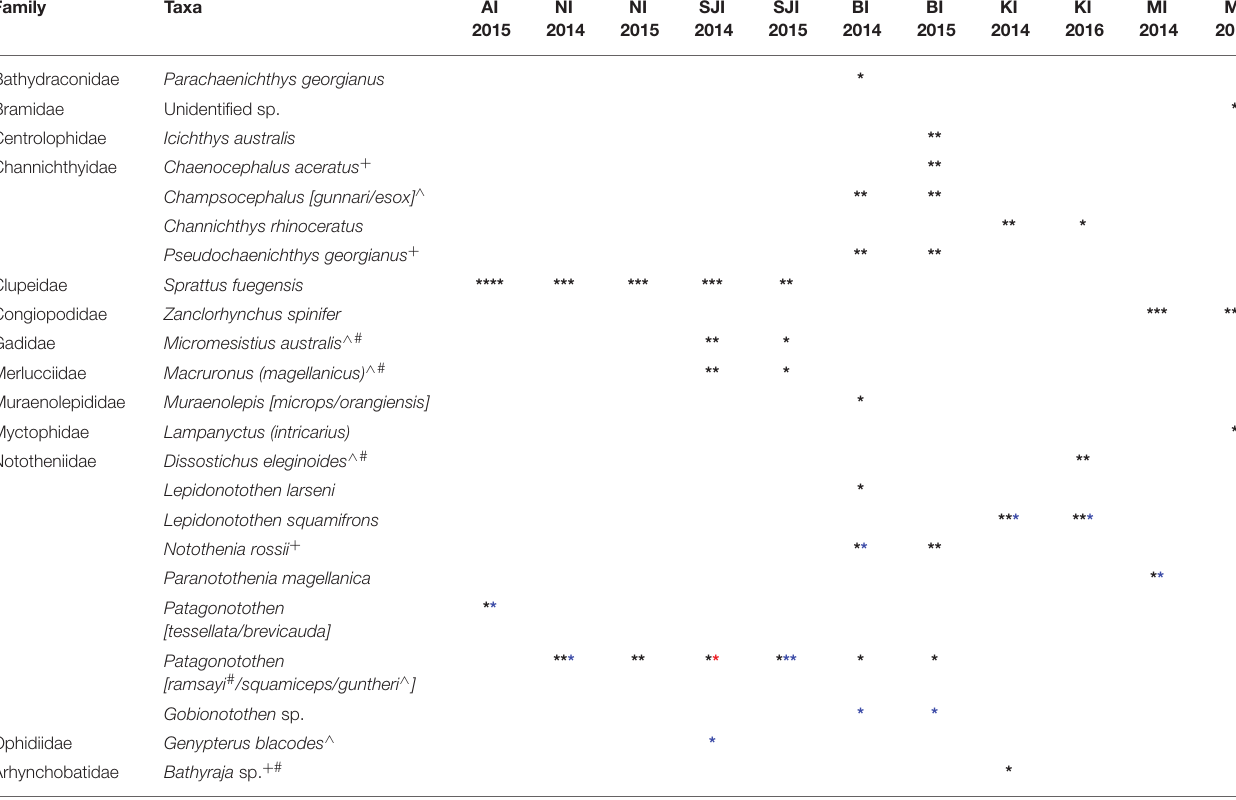
TABLE 4 | Main fish prey at each sampling colony of black-browed albatrosses.